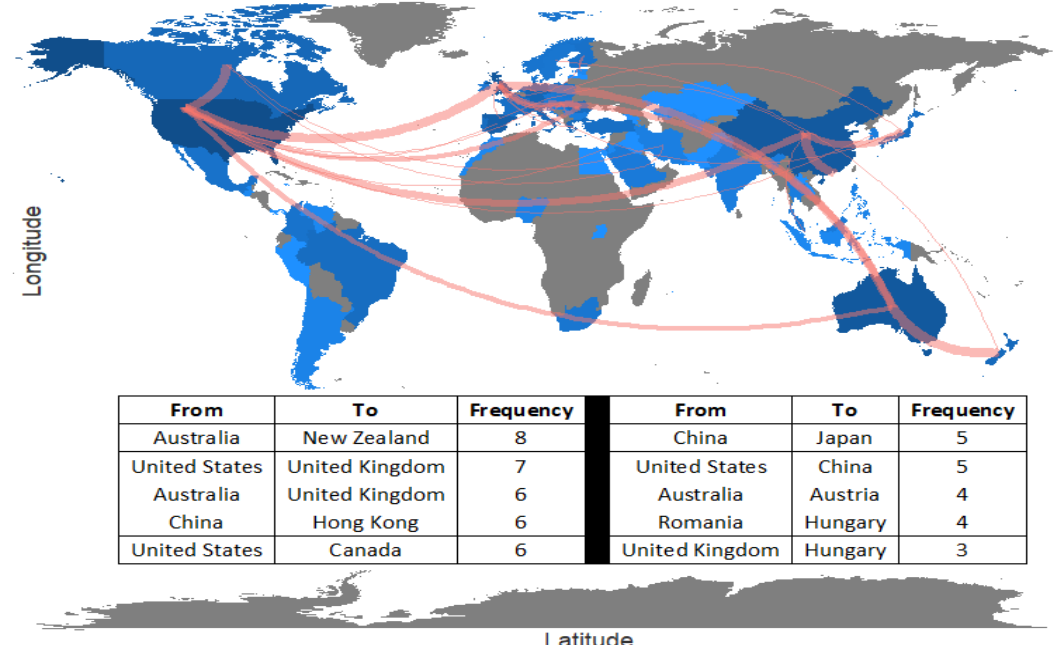
Figure 4. Country collaboration Map.